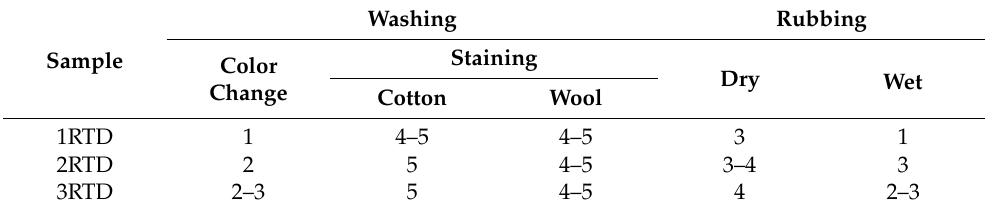
Table 10. Results of washing and rubbing fastness tests of samples with pre-mordanting, post- mordanting and mordanting during dyeing with common